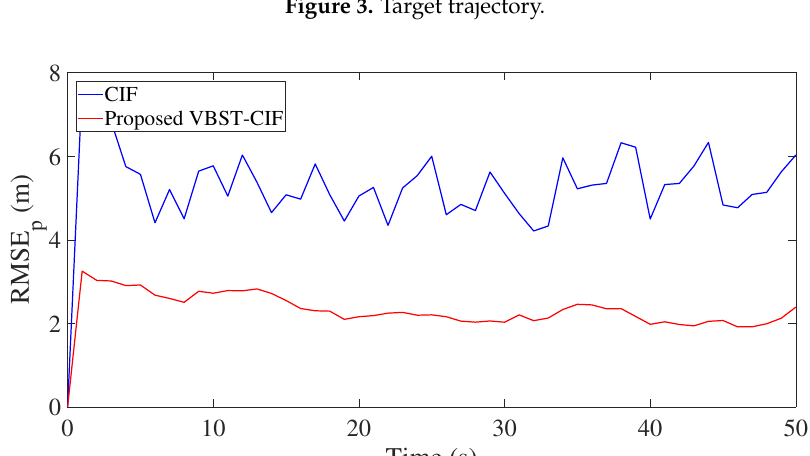
Figure 3. Target trajectory.